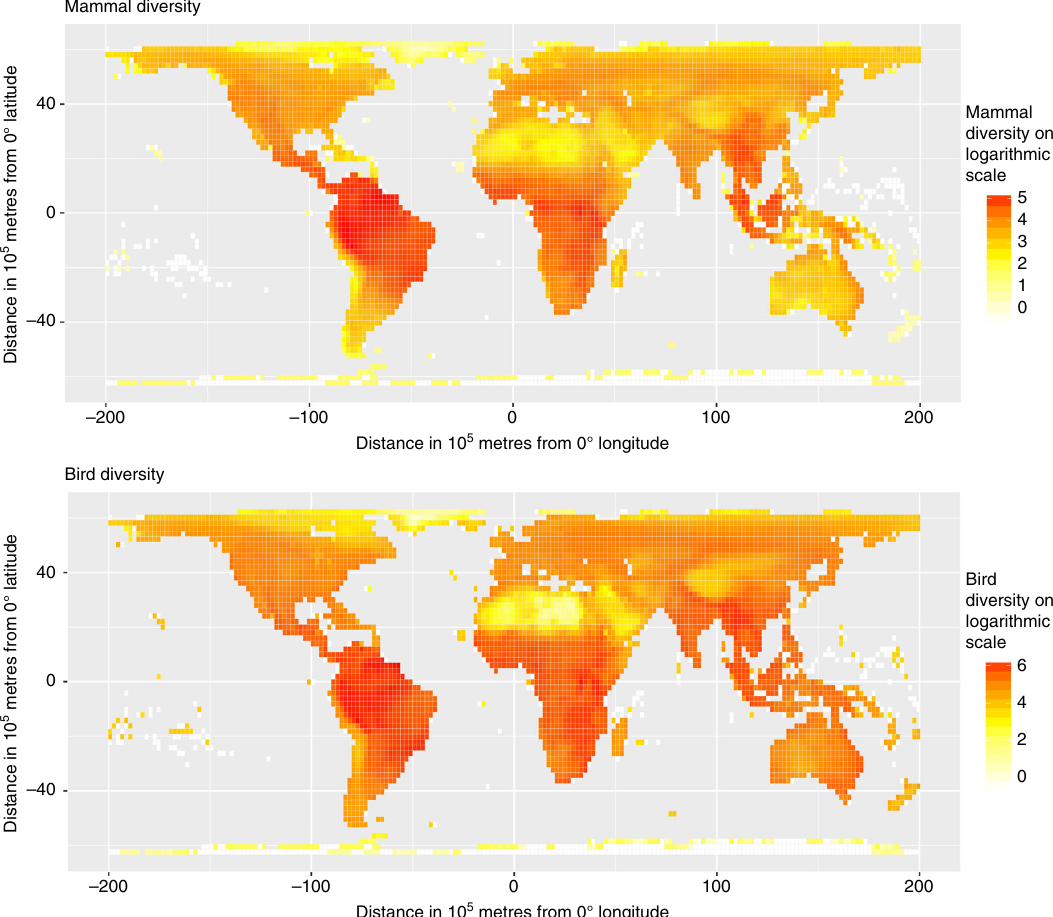
Fig. 2 Global distribution of mammal diversity and bird diversity. Values on logarithm scale of number of species are shown for 200 × 200 km cells of an equal-area grid. For amphibian and plant diversity see Supplementary Figure